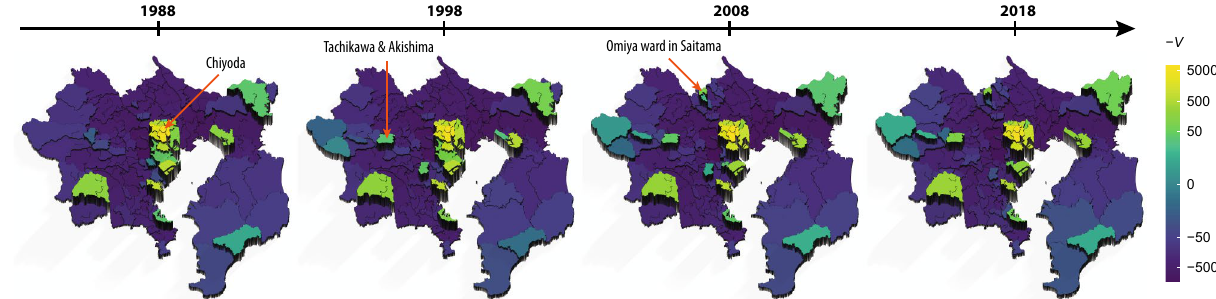
Figure 4. Time-evolution of the potential landscape in Tokyo metropolitan area. The potentials are obtained from the home-work trips of successive surveys over 30 years in the Tokyo metropolis and surrounding provinces. Each zone is basically equal to a municipal